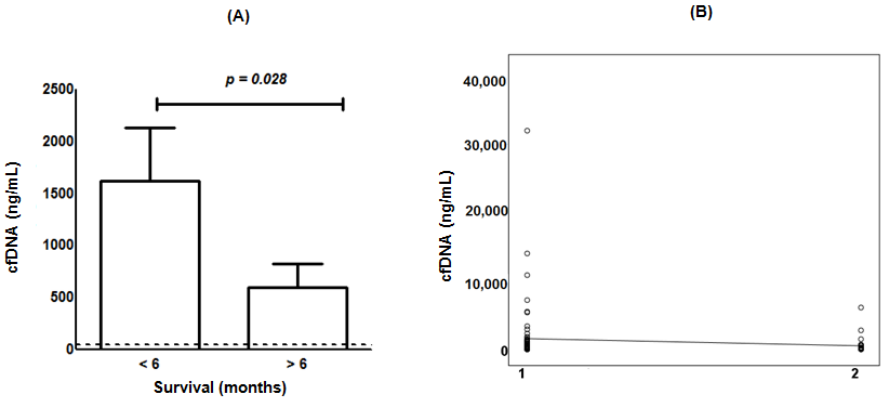
Figure 3. Circulating cfDNA level and GBM survival during ITN-POH therapy (mean values ± standard error). ( A ) cfDNA levels for GBM survivors of less than 6 months (1626 ± 505 ng/mL) and more than 6 months (599 ± 221 ng/mL). Dotted line indicates the control cfDNA level. ( B ) Respective correlation 1: <6 months; 2: >6 months; rho = − 0.225; p = 0.024).